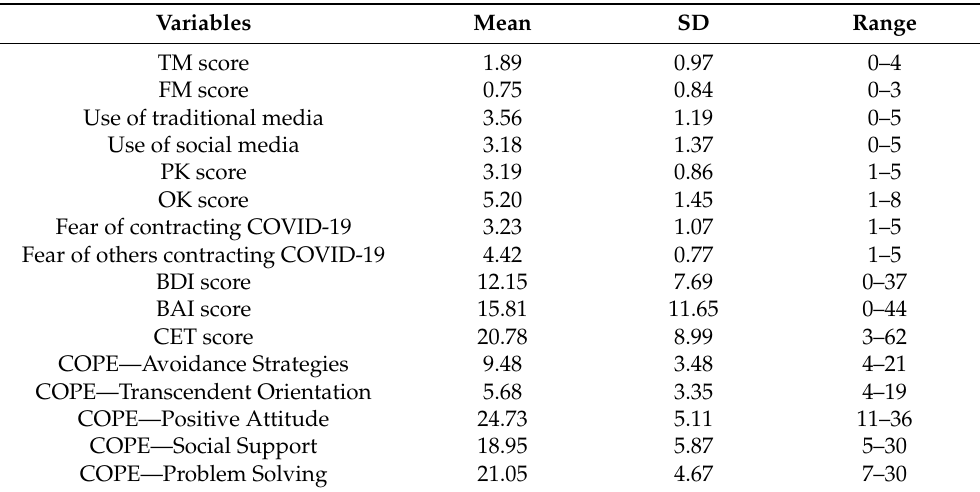
Table 1. Descriptive